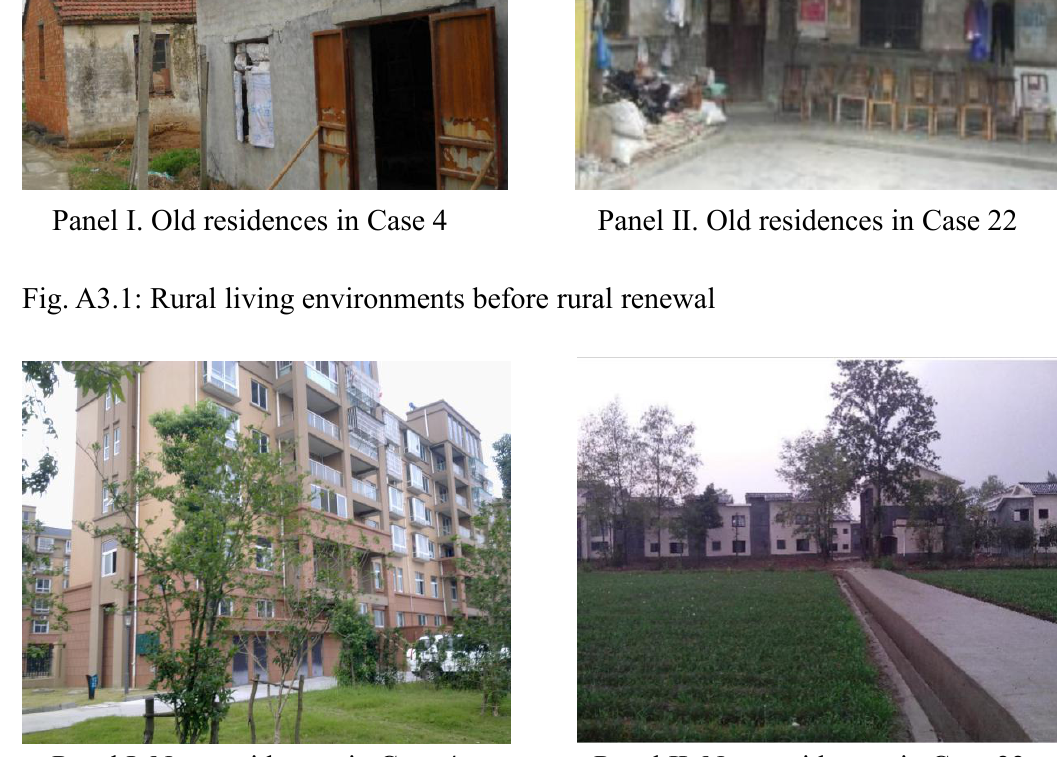
Panel Ⅰ. New residences in Case 4 Fig. A3.2: Rural living environments after rural